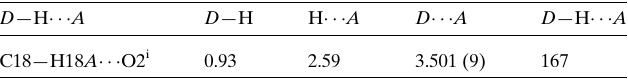
Table 1 Hydrogen-bond geometry (A˚ , (cid:3) ).